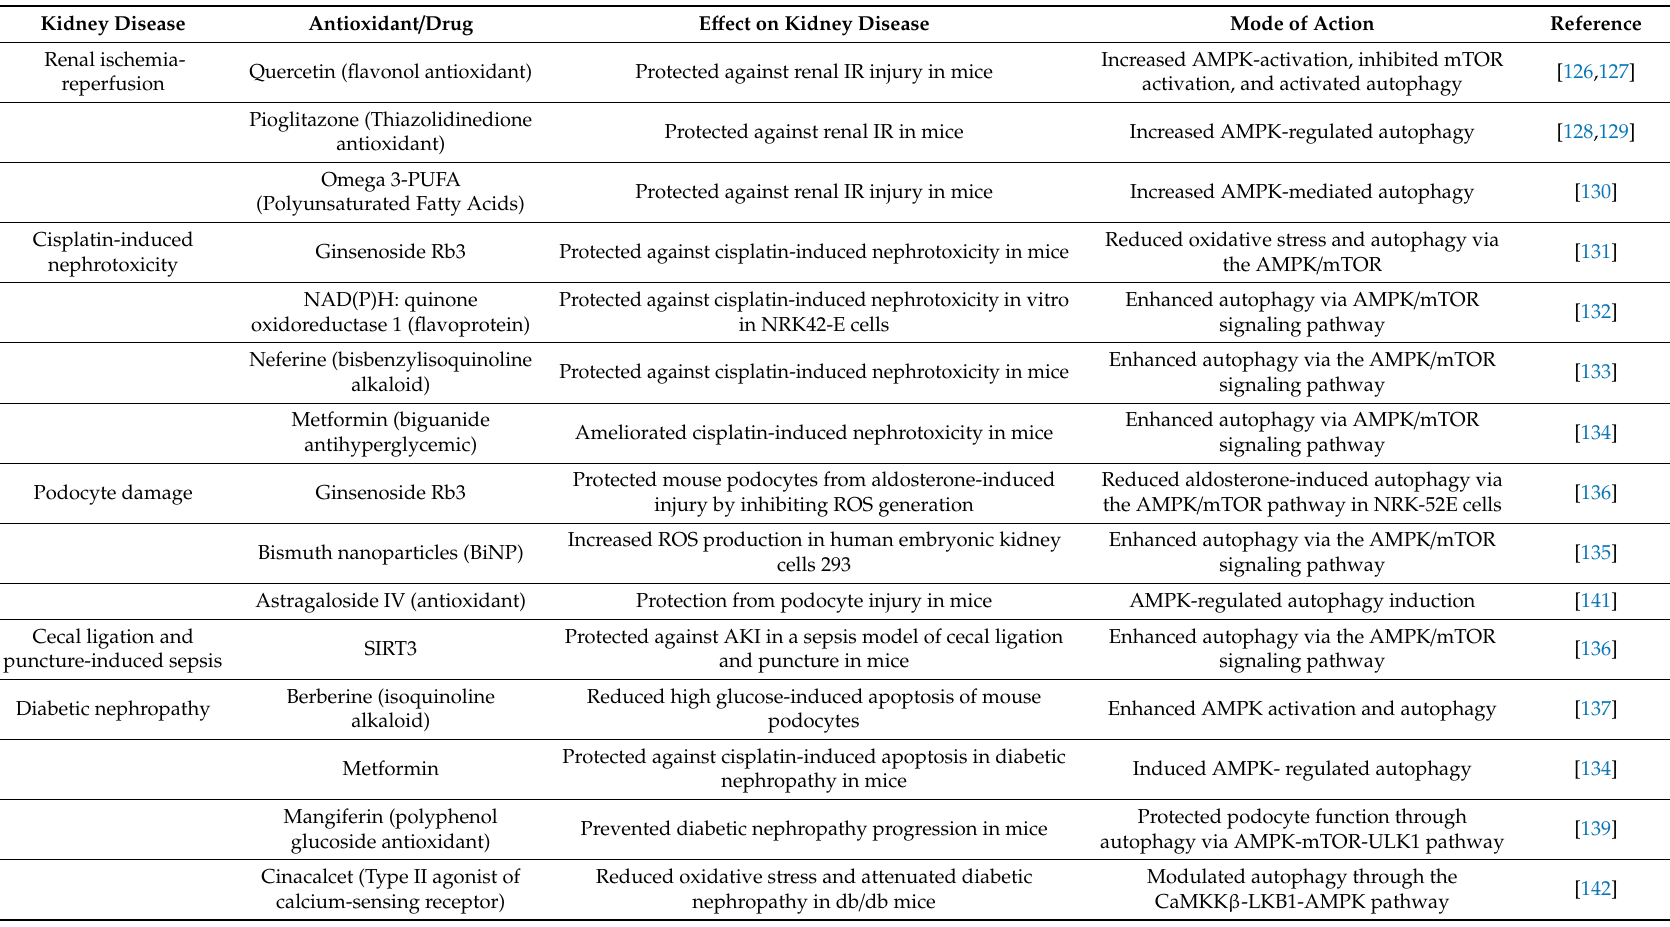
Table 2. Impact of antioxidants / drugs on AMPK-mTORC1-ULK1 pathway of autophagy in kidney